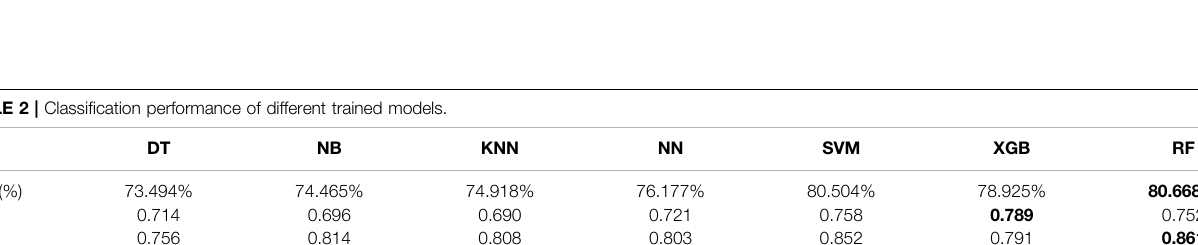
FIGURE5| Heatmapofthelogoddsscoresof2-mersabundantinthepositiveversusnegativedatasets.Intheheatmap,aredcolor(highlogoddsscore)denotes 2-mers overrepresented in AHTPs compared to non-AHTPs, and a white color (low log odds score) denotes 2-mers underrepresented in AHTPs compared to non- AHTPs.